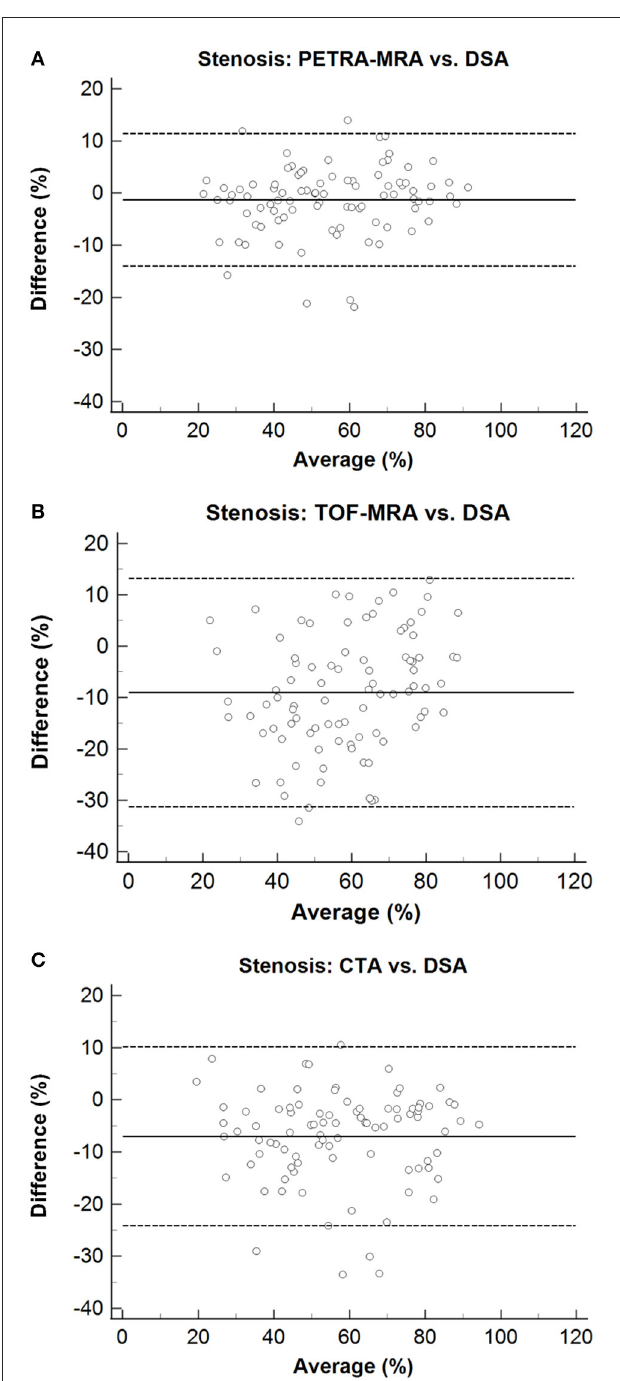
FIGURE2 Bland–Altman plots for stenosis of PETRA-MRA, TOF-MRA, and CTA, compared with the DSA as the reference standard. The solid lines represent the mean difference, and the dashed lines indicate the 95% confidence interval. The measurements of the degree of stenosis on PETRA-MRA indicated the smallest variance with DSA and shortest LOA compared with those on TOF-MRA and CTA [CV: 11.8% vs. 19.4% and 15.2%; LOV: ( − 14.0, 11.4) vs. ( − 31.3, 13.2) and ( − 24.1.10.2)]. (A) Stenosis: PETRA-MRA vs. DSA, (B) Stenosis: TOF-MRA vs. DSA, (C) Stenosis: CTA vs. DSA.